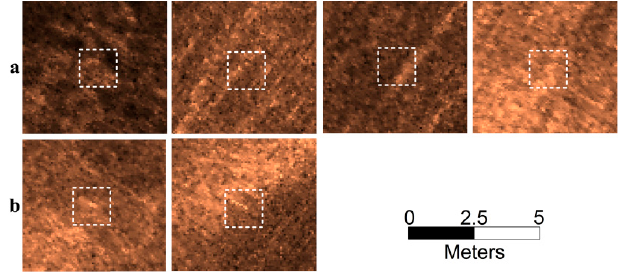
Figure 7. Examples of false positive detections (false alarms) regarding: ( a ) Model 3 and ( b ) Model 4.